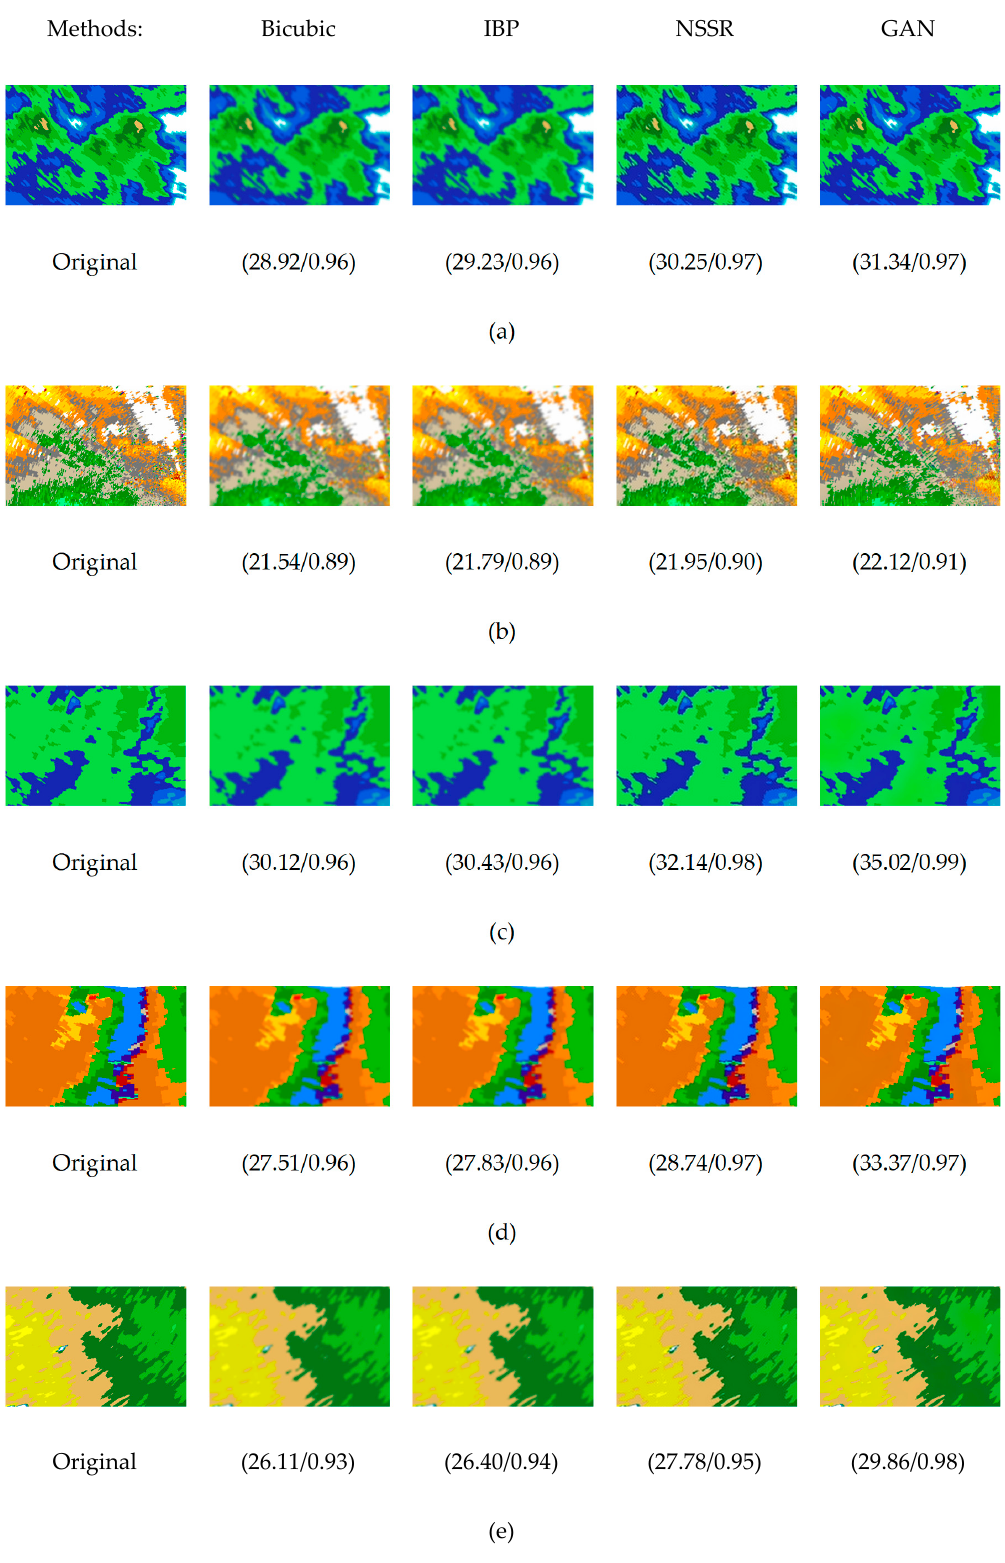
Figure 7. Same with Figure 6. Cropped patch of reconstructed results with the upscaling factor of × 2. ( a – e ) reconstructed result patch using image from Figure 4a–e ( ×